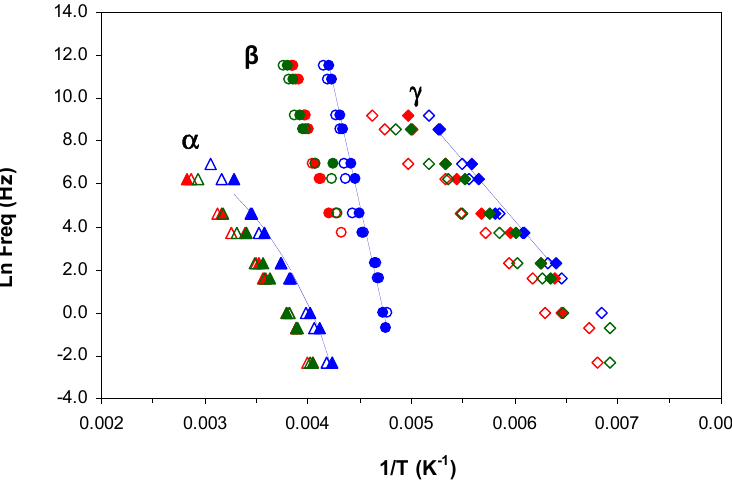
Figure 7. Relaxation map for PEI800 (blue), PEI2000 (green), and PEI25000 (red) at heating rates of 0.5 °C/min (filled symbols) and 2 °C/min (open symbols).